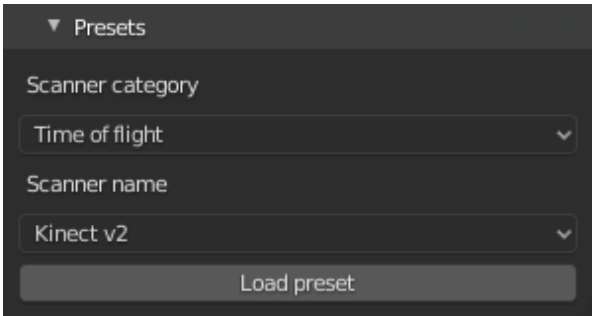
Figure 6. Screenshot of the Sensor Presets Selection Menu. After selecting a sensor category, the sensor name can be used to select a preset. By pressing the button to load the preset, the preset is